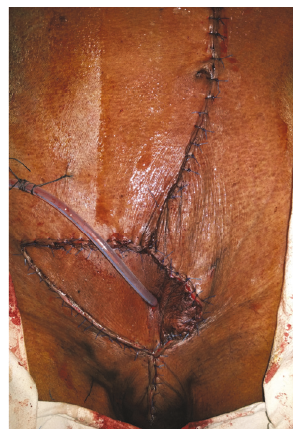
Figure 6: Photograph of completion of reconstruction, showing that the urinary catheter is exteriorized through the flap.